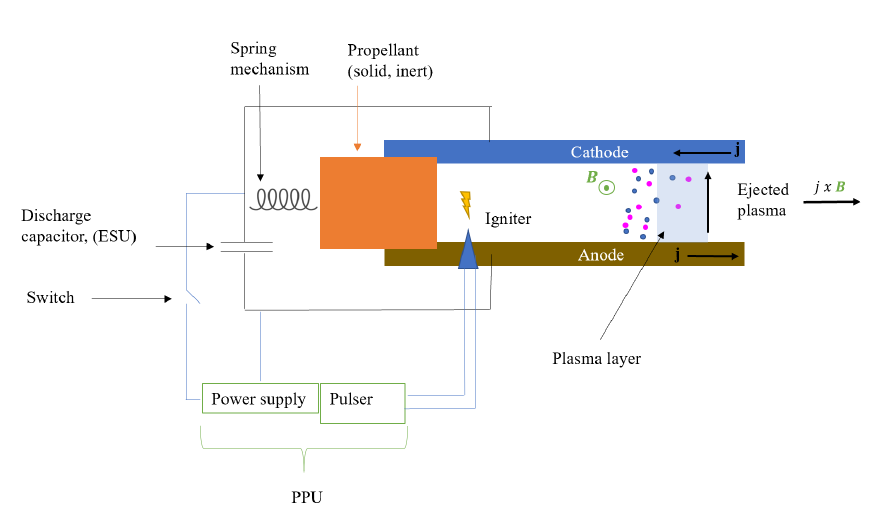
Figure 11. A parallel plate pulsed plasma thruster as a simplified schematic